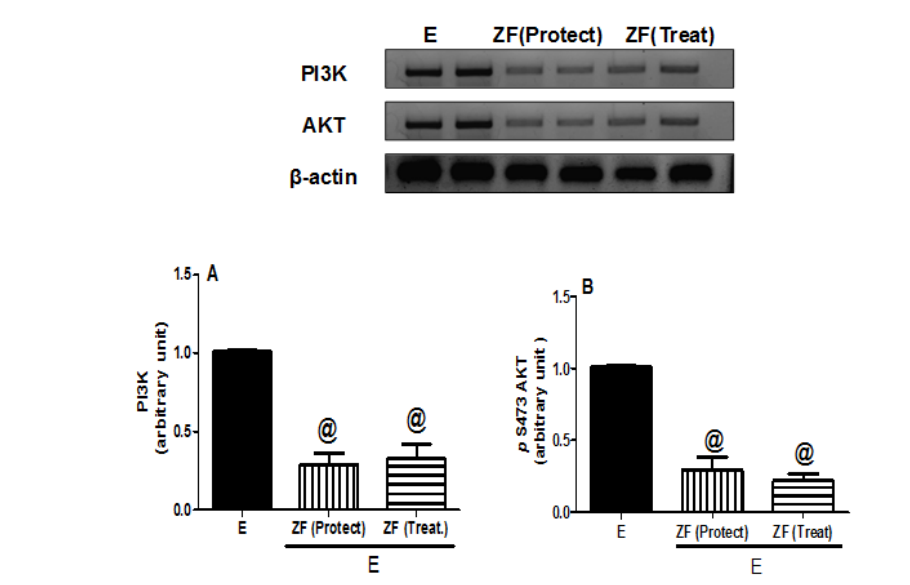
FIGURE 5 - Effect of ZF on intratumoral protein expression of PI3K and p-(S473) Akt